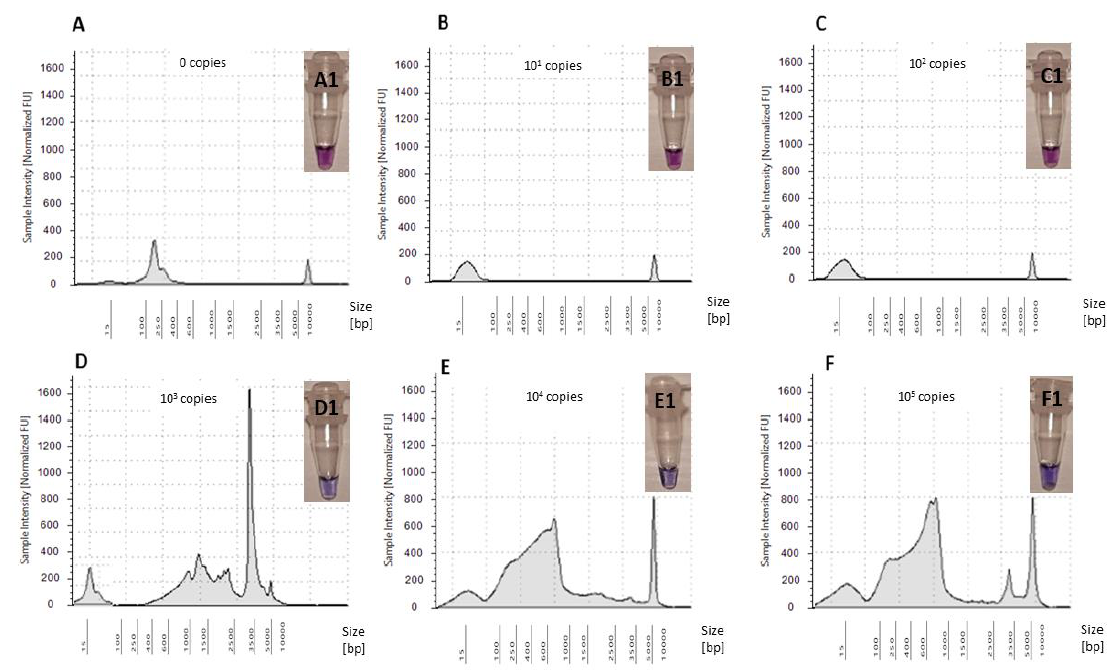
Figure 5. Electropherograms of NTC and five OsHV-1 plasmid standard amplifications in LAMP